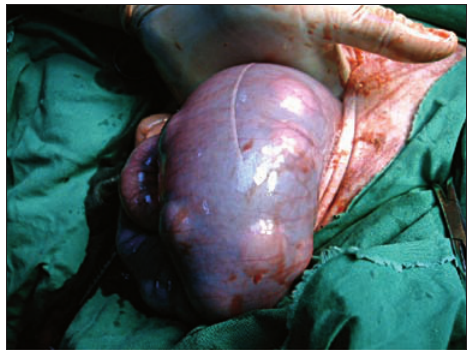
Fig. 3. In utero transplantation using the midline celiotomy